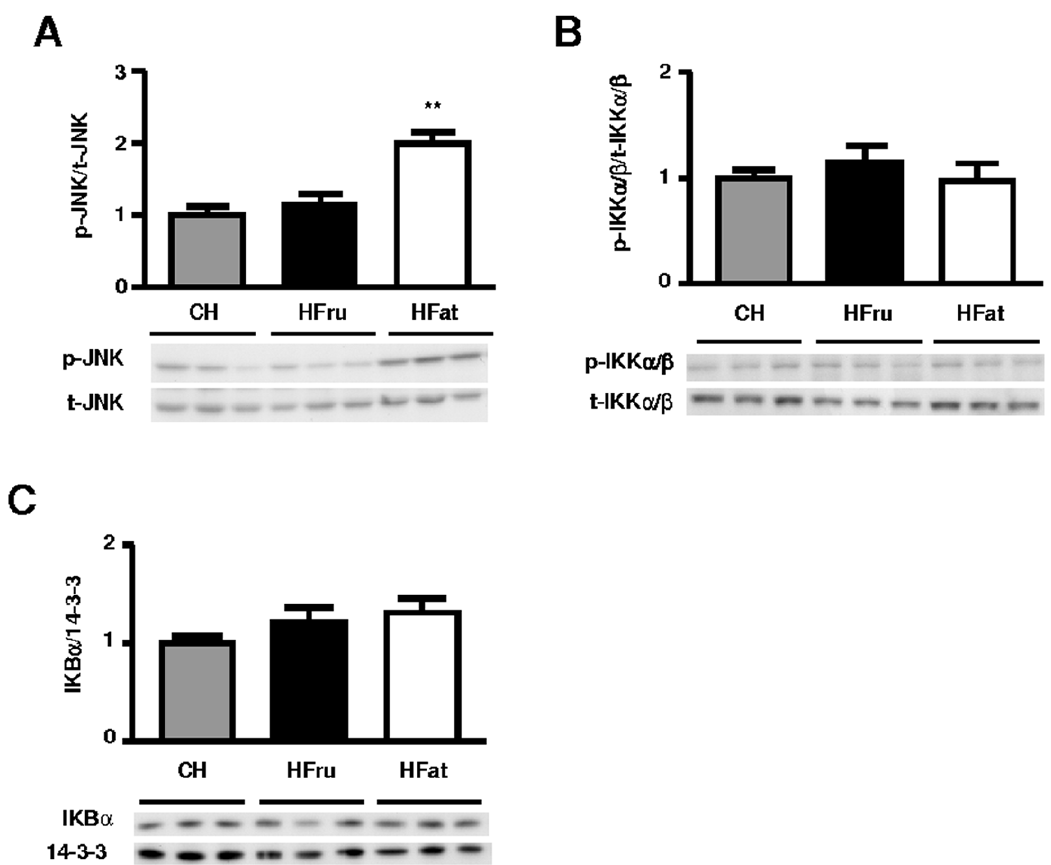
Figure 6. Effects of HFru and HFat on JNK and IKK activation. After one week of HFru or HFat feeding, liver homogenates were immunoblotted for p-JNK/t-JNK ( A ), and p-IKK a / b /t-IKK a / b ( B ) and t-IKB a ( C ). Each lane represents a single mouse. Densitometry data are mean 6 SE of 6 mice per group. ** p , 0.01 vs CH fed mice.